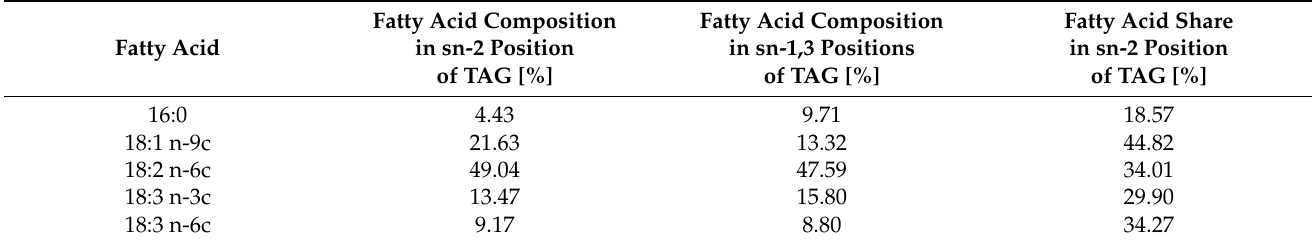
Table 3. Fatty acids composition in sn-2 and sn-1,3 positions of TAG and the share of fatty acids in internal position (sn-2) of TAG in black currant seed oil.